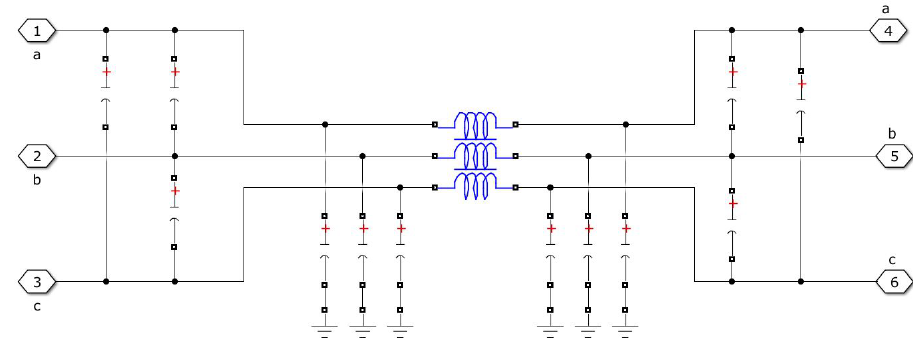
Figure 9. Representation of the π -type transmission line model used in